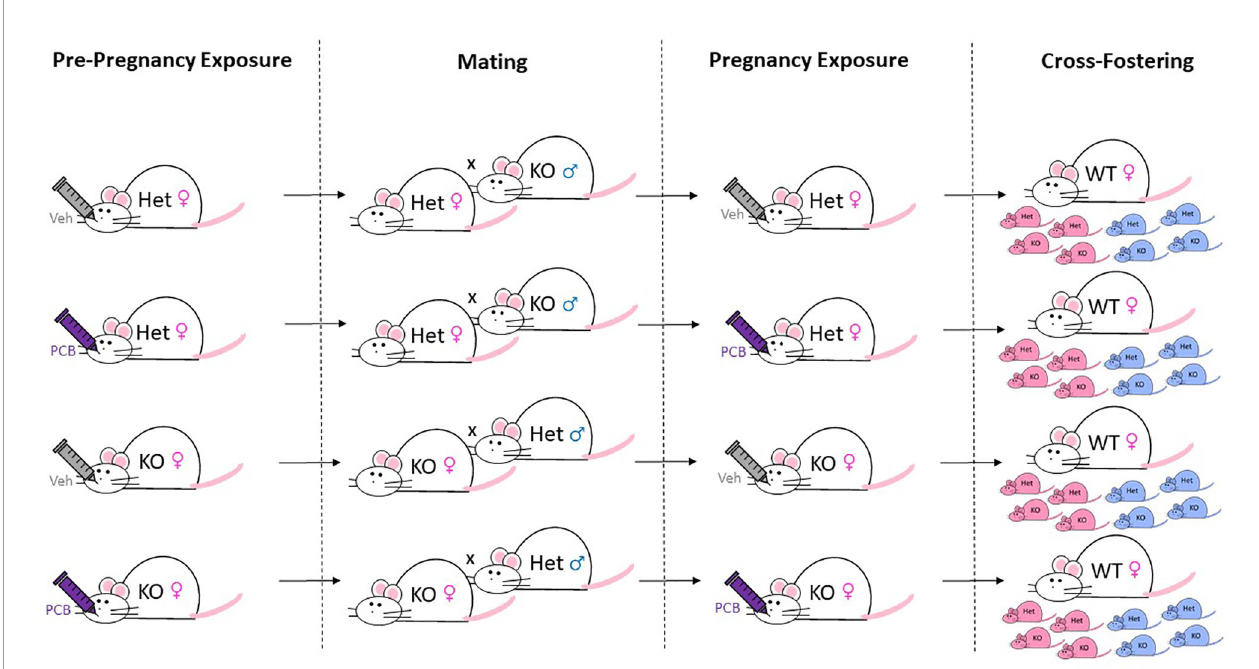
FIGURE 1 | Breeding, Exposure, and Cross-Fostering Scheme. Whole-body Nrf2 heterozygous (+/-) and Nrf2 knockout (-/-) female ICR mice were exposed to 1 µmol/kg of PCB126 or saf fl ower (vehicle) three days prior to mating and on gestation day ~10. For breeding, female mice were housed with male mice of opposing Nrf2 genotype for a week. Shortly after birth, litters containing more than eight pups underwent culling to ensure postnatal food availability. Remaining offspring were then cross-fostered to unexposed Nrf2 wild-type dams to prevent PCB exposure during nursing. The fi gure denotes 50% Het and 50% KO (as well as male and female) offspring as an example for each litter, but actual litters did not always have this breakdown of